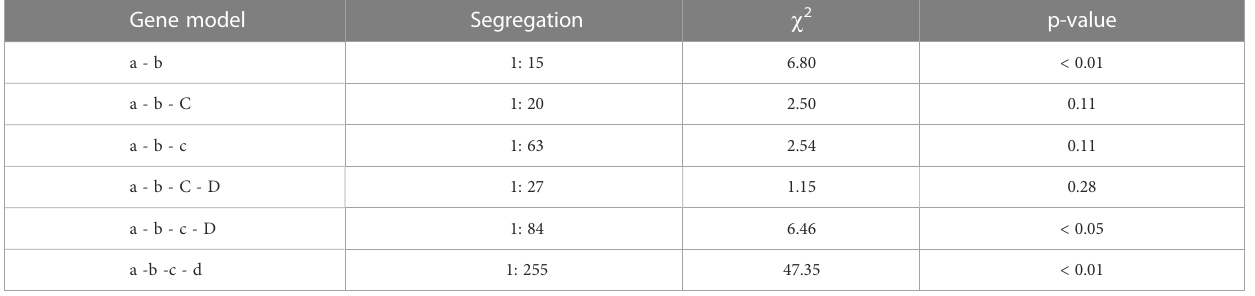
TABLE 1 Comparison of observed 7-epizingiberene segregation to theoretical